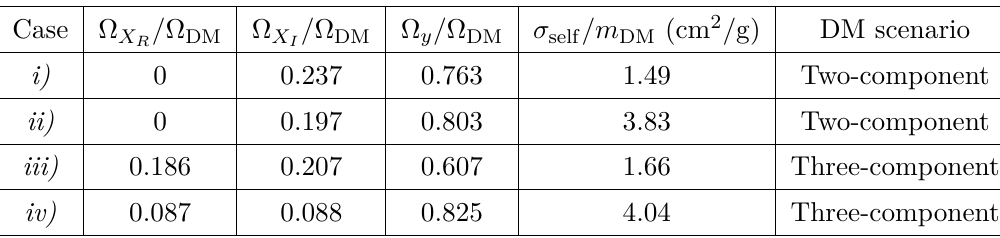
and X , cases I R